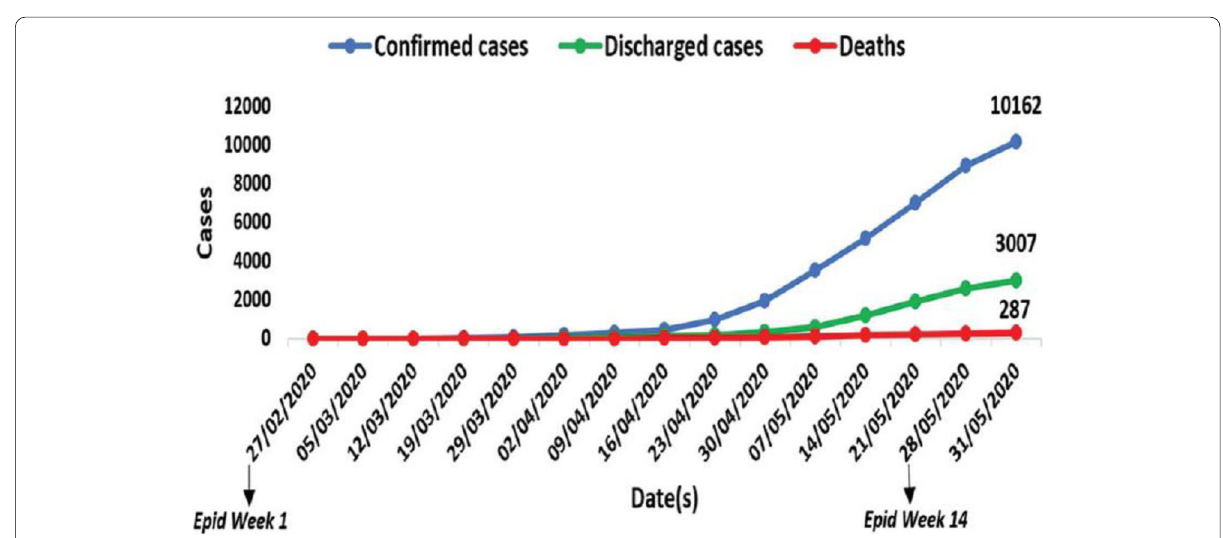
Fig. 2 Spread of confirmed Covid‑19 cases, discharges, and deaths across Nigeria from 27 th February to 31 st May 2020